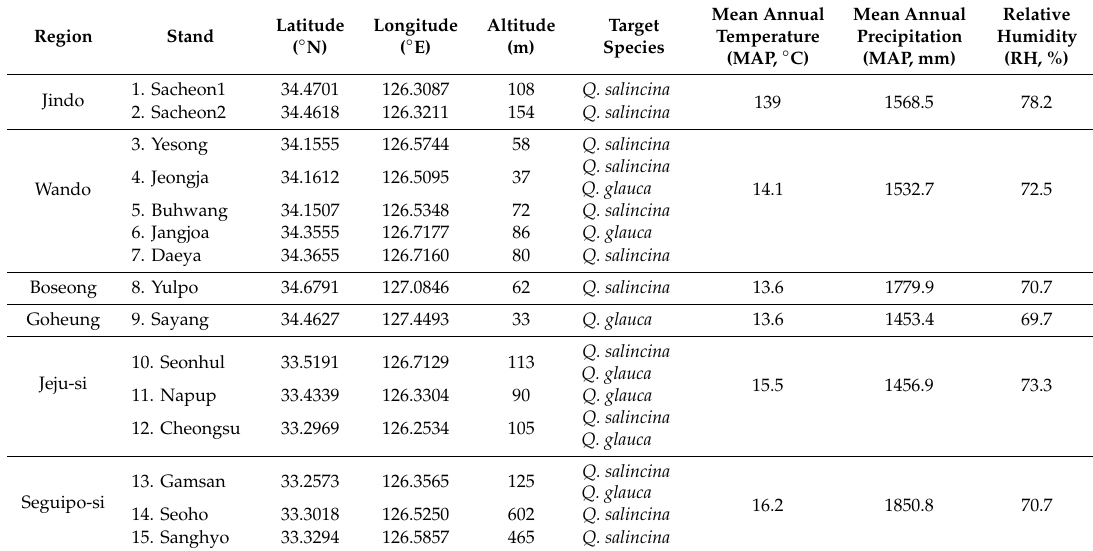
Table 1. List of 15 candidate stands of Q. salicina and Q. glauca stands used in this study. Region Stand